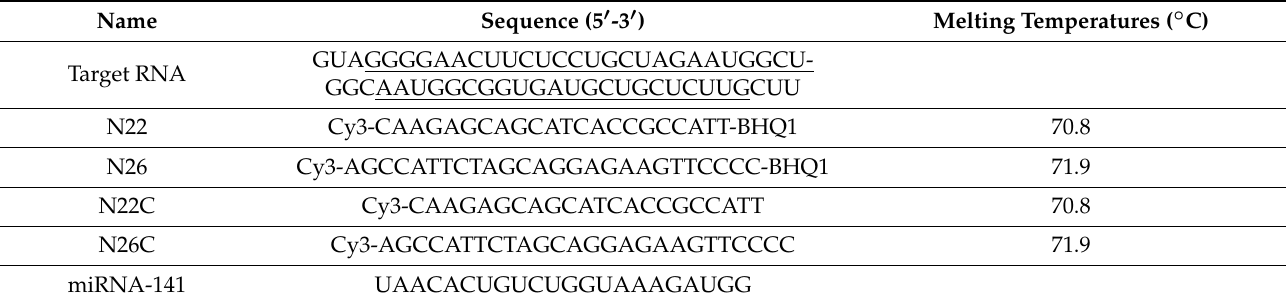
Table 1. The sequences of RNA and DNA oligonucleotides.